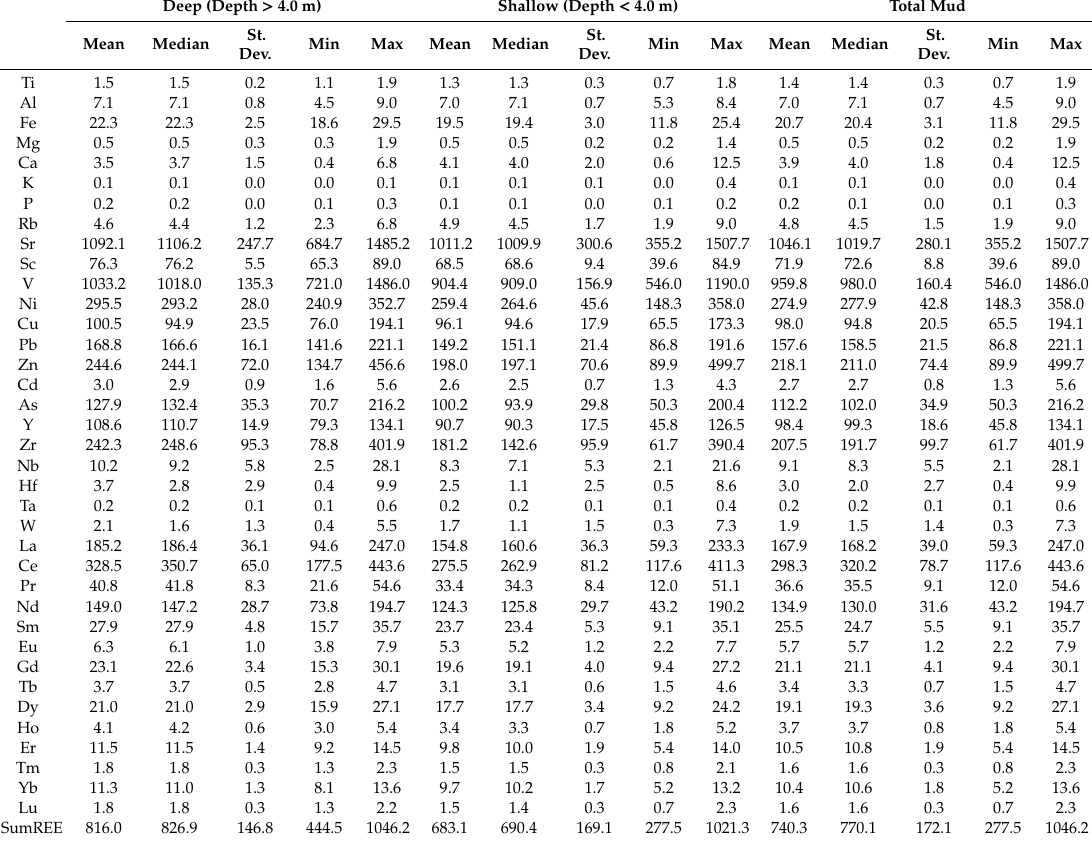
Table 1. Representative concentrations and statistical parameters of the studied elements in the Alm á sfüzit˝o red mud at di ff erent horizons (major elements in m / m%, trace elements in ppm). Deep (Depth > 4.0